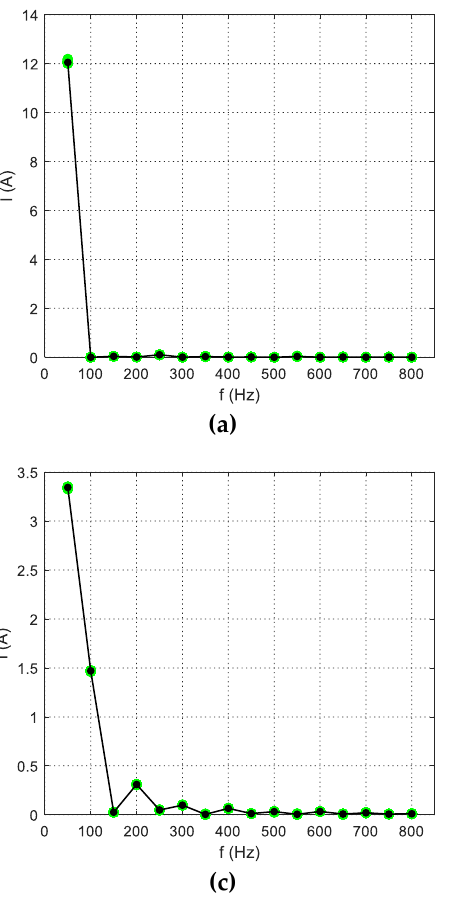
Figure 17. Current harmonic components (1 – 16) of ( a ) electric kettle; ( b ) iron; ( c ) hairdryer; ( d ) vacuum cleaner.